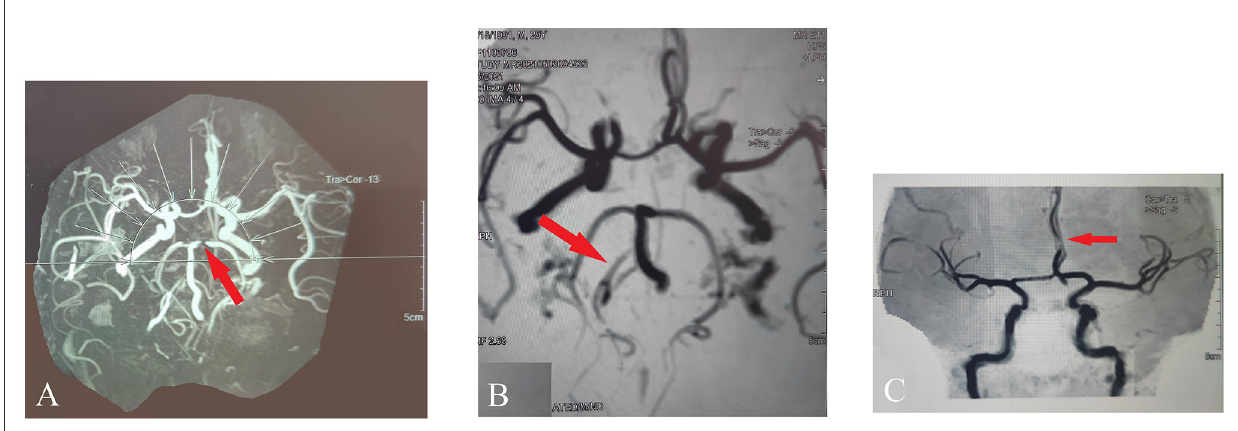
FIGURE1 MRA revealed the artery’s condition. (A) Localized stenosis of P1 segment of bilateral posterior cerebral arteries. (B) Slender right vertebral artery. (C) Localized stenosis in the A2 segment of the bilateral anterior cerebral artery.